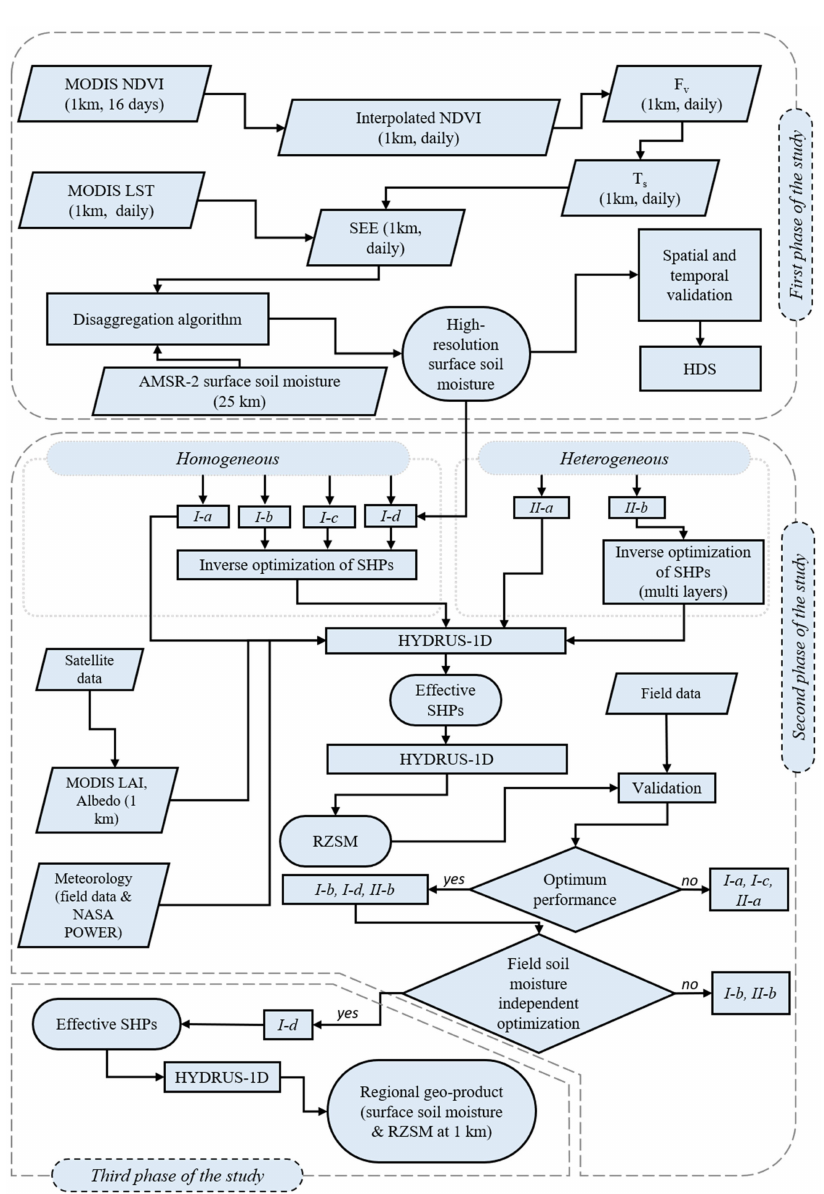
Figure 7. Outline of the methodology of the present study. I-a, I-b, I-c, I-d, II-a , and II-b are explained in Section 3.2. Refer to Figure 5 for details about the treatments and resolution of the input and output